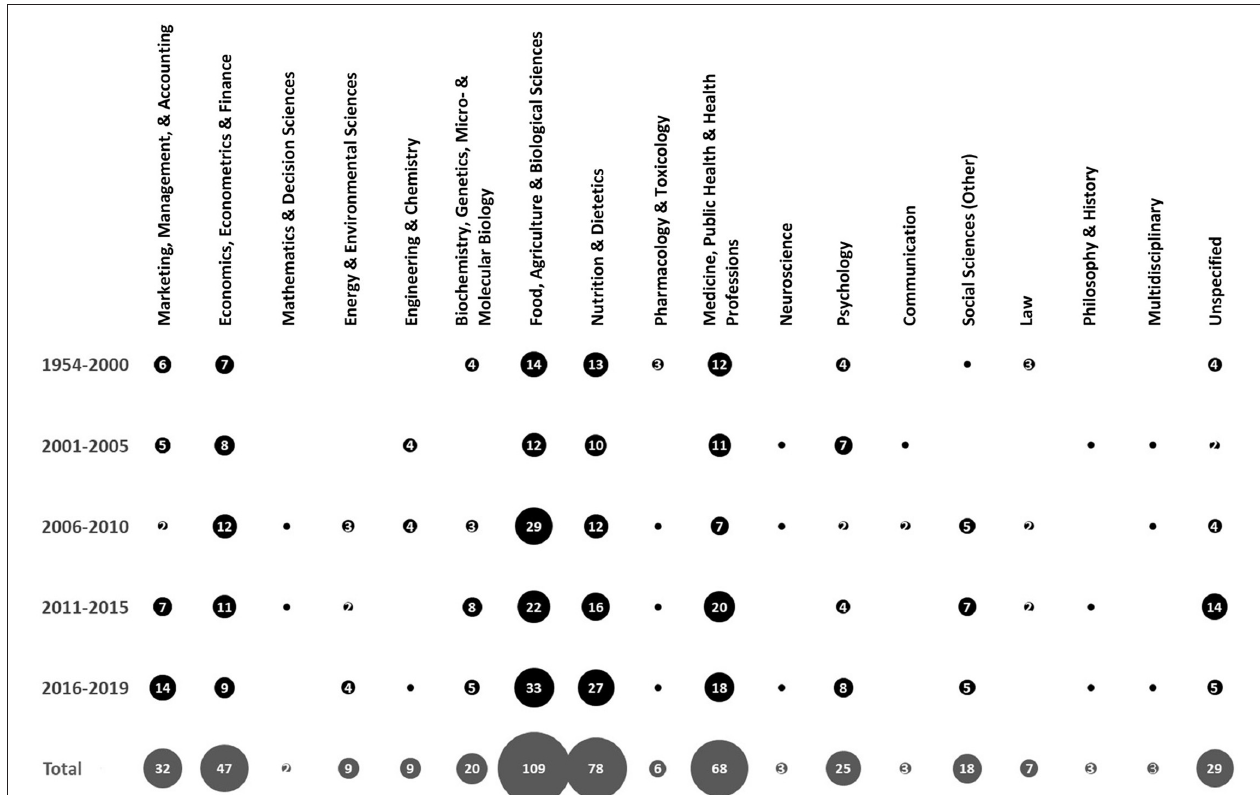
FIGURE 3 | Prevalence of research in each discipline during each period (i.e., 1954–2000, 2001–2005, 2006–2010, 2011–2015, and 2016–2019) and in total (i.e., between 1954 and 2019). Numbers in bubbles specify the prevalence. Note that bubbles with no number represent only one